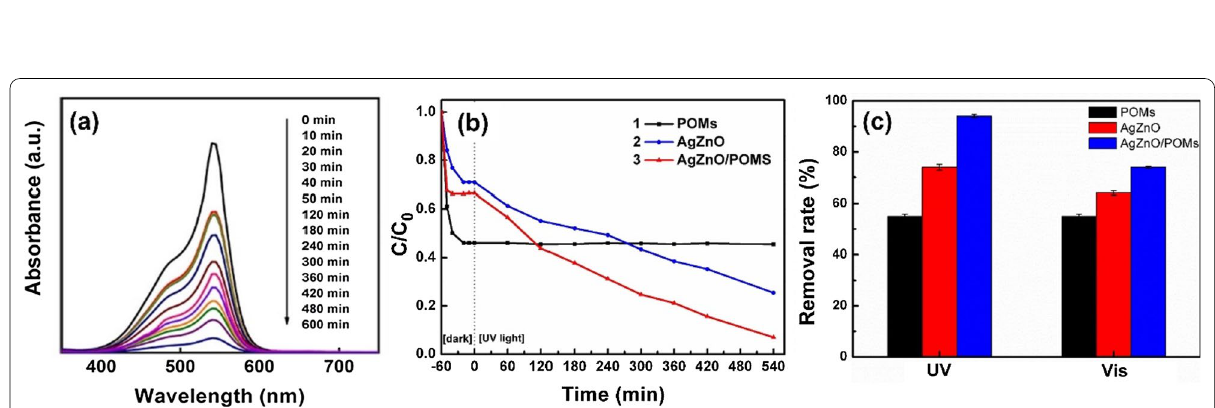
Fig. 7 a UV–Vis absorption spectra of BM solution containing the AgZnO/POMs nanocomposites, b removal curves of different materials for removing BM, curve: (1) POMs, (2) AgZnO, (3) AgZnO/POMs nanocomposites (The experiment was repeated three times), c Histogram of the removal of BM by POMs, AgZnO and AgZnO/POMs nanocomposites under UV and Vis irradiation (The experiment was repeated three times)